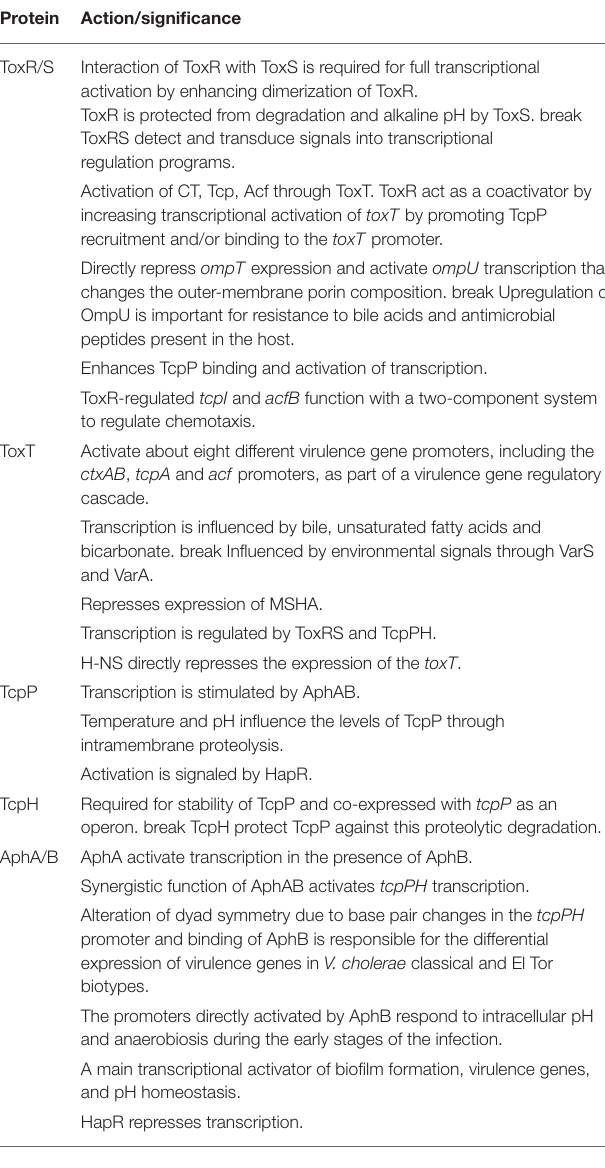
TABLE 1 | Interaction of ToxRS, ToxT, TcpPH, and other virulence related proteins/genes in V. cholerae . Protein Action/significance